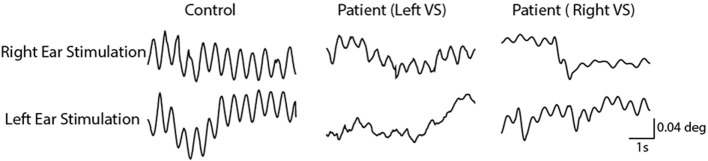
Torsional eye movements evoked by EVS stimulation. EVS induces a sensation of head roll about the naso-occiptal axis, evoking a torsional eye response. A control subject's torsional eye response to right and left ear stimulation were similar in magnitude. However, the vestibular schwannoma patients show a reduced response magnitude during ipsilesional stimulation.